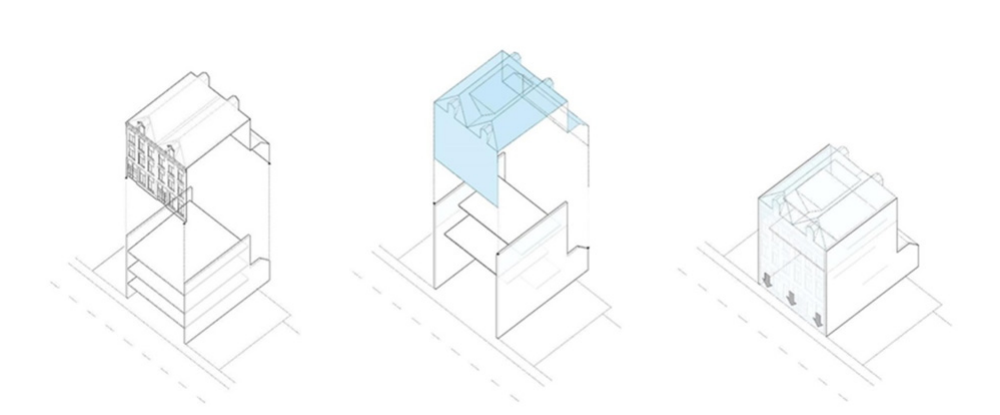
Fig. 1 Illustration by MVRDV of the concept behind the glass brick